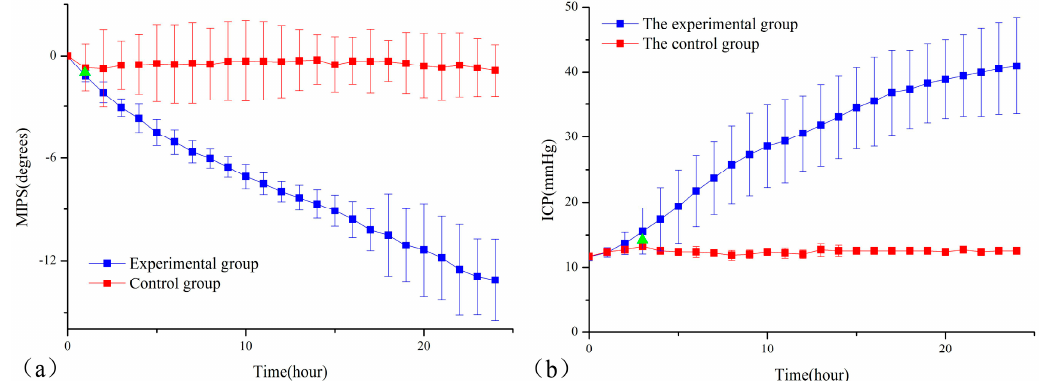
Figure 6. The mean ± standard deviation 24 h trends of MIPS and ICP. The green triangle indicated the time of a significant difference between the experimental group and control occurred. ( a ) Comparison of MIPS in experimental group and control group rabbit; ( b ) Comparison of ICP in experimental group and control group rabbit. Table 1. BWC results from the experimental rabbits and the control rabbits at the 24th hour.